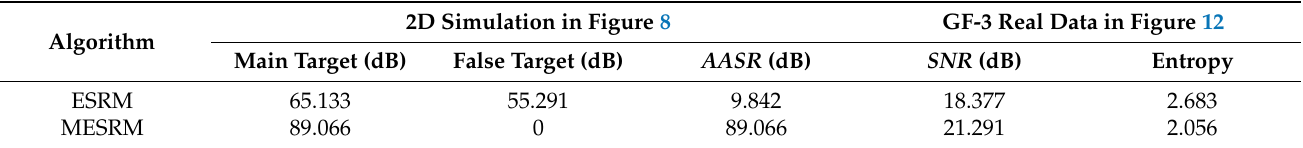
Table 3. The statistical analysis of the imaging